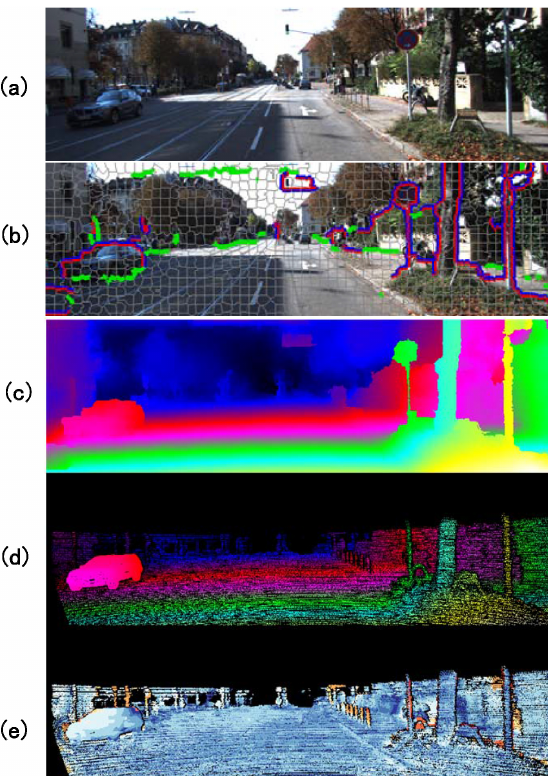
Figure 9. Qualitative results of our improved slanted plane model. (a) Left image; (b) Segments and boundaries; (c) Disparity map; (d) Ground truth; (e) Error